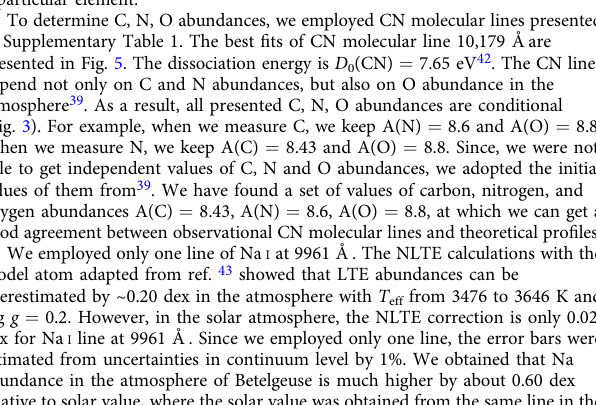
The microturbulent velocity, V mic = 3 km s − 1 , was obtained from Fe I lines listed in Supplementary Table 4. The synthetic pro fi les were convolved with a pro fi le that combines a rotational broadening of 5 km s − 1 and broadening by macroturbulence with a radial-tangential pro fi le. Macroturbulence is introduced to reproduce the line pro fi le shape, and it does not affect the derived element abundance, if the line pro fi le is fi tted well. For different lines of Fe I , the macroturbulence velocity, V mac , was varied between 10 and 15 km s − 1 . Supplementary Fig. 4d demonstrates the iron abundances vs. the excitation energy ( E exc ) of the lower level for the investigated Fe I lines for two epochs of observations: 14-02-2012 and 31-01-2020. In both epochs, there is no trend for A (Fe) vs. E exc and the mean values of iron abundances are A(Fe) = 7.51 ±0.11 and A (Fe) = 7.53± 0.15. Iron abundances from individual lines at all epochs of observations are presented in Supplementary Table 5. Using the same line list, we obtained A(Fe) = 7.41 ± 0.09 for the Sun.